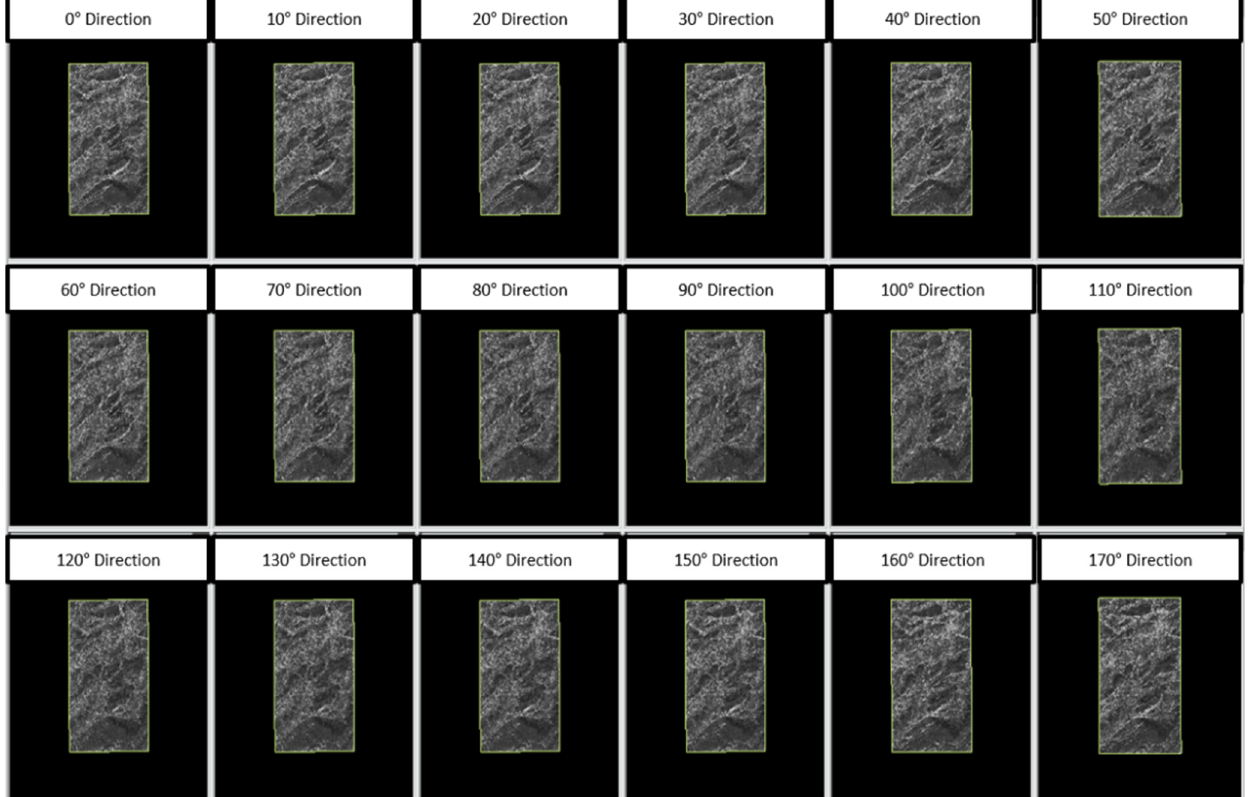
Figure 3. Amplitude contrast for specific azimuth direction. A change in amplitude contrast is shown when the azimuth direction increases from 0° to 170° at 10° intervals.